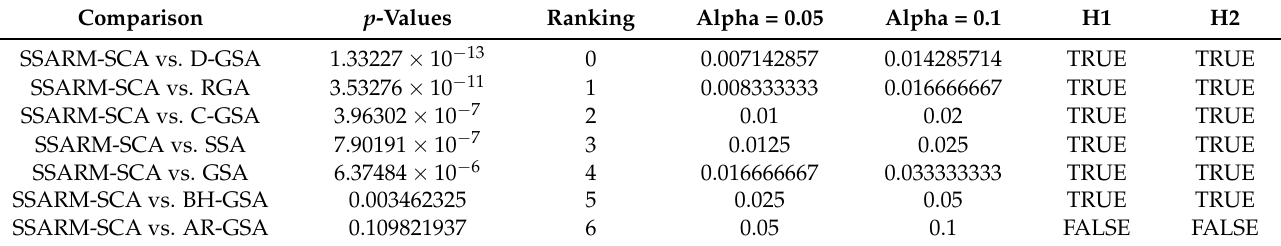
Table 8. Results of the Holm’s step-down